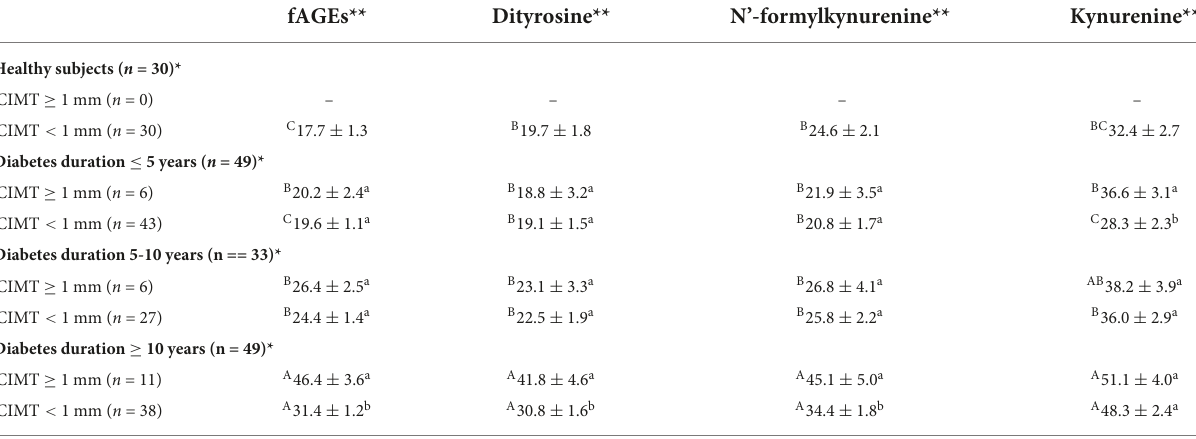
TABLE 4 Fluorescence intensities of advanced glycation end products (AGEs) and protein oxidation products (POPs) in patients with carotid intima media thickness (CIMT) ≥ 1 and < 1 mm.